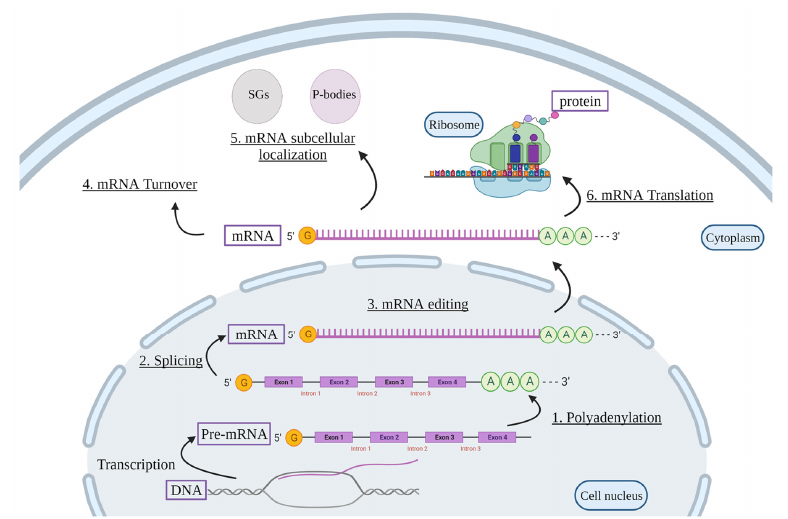
Figure 1. Cellular functions of RBPs. RBPs are involved in post-transcriptional regulation of target mRNAs. Pre-mRNA is first transcribed from the DNA. Then, RBPs regulate the production of mature mRNA via polyadenylation ( 1 ), splicing ( 2 ), and mRNA editing ( 3 ). RBPs can also regulate mRNA stability ( 4 ) and mRNA subcellular localization ( 5 ) within the cell in SGs or P-bodies, as well as mRNA translation into proteins ( 6 ). Pre-mRNA, precursor mRNA; SGs, stress granules; P-bodies, processing-bodies. Created with BioRender.com.